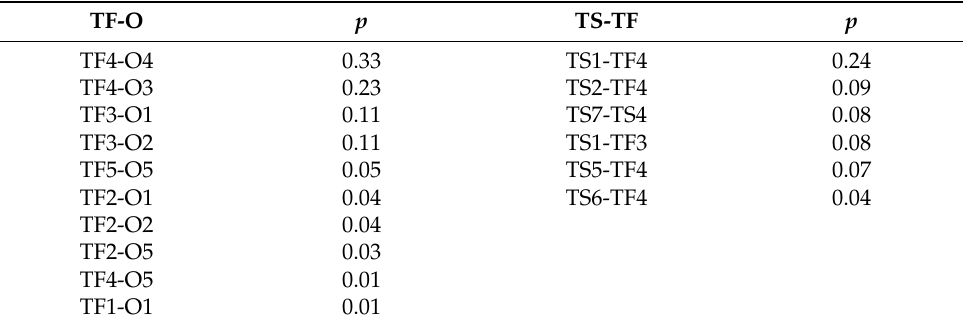
Table 8. Asymptotic probabilities of frequent screens, finishing moves and outcomes. TF-O p TS-TF